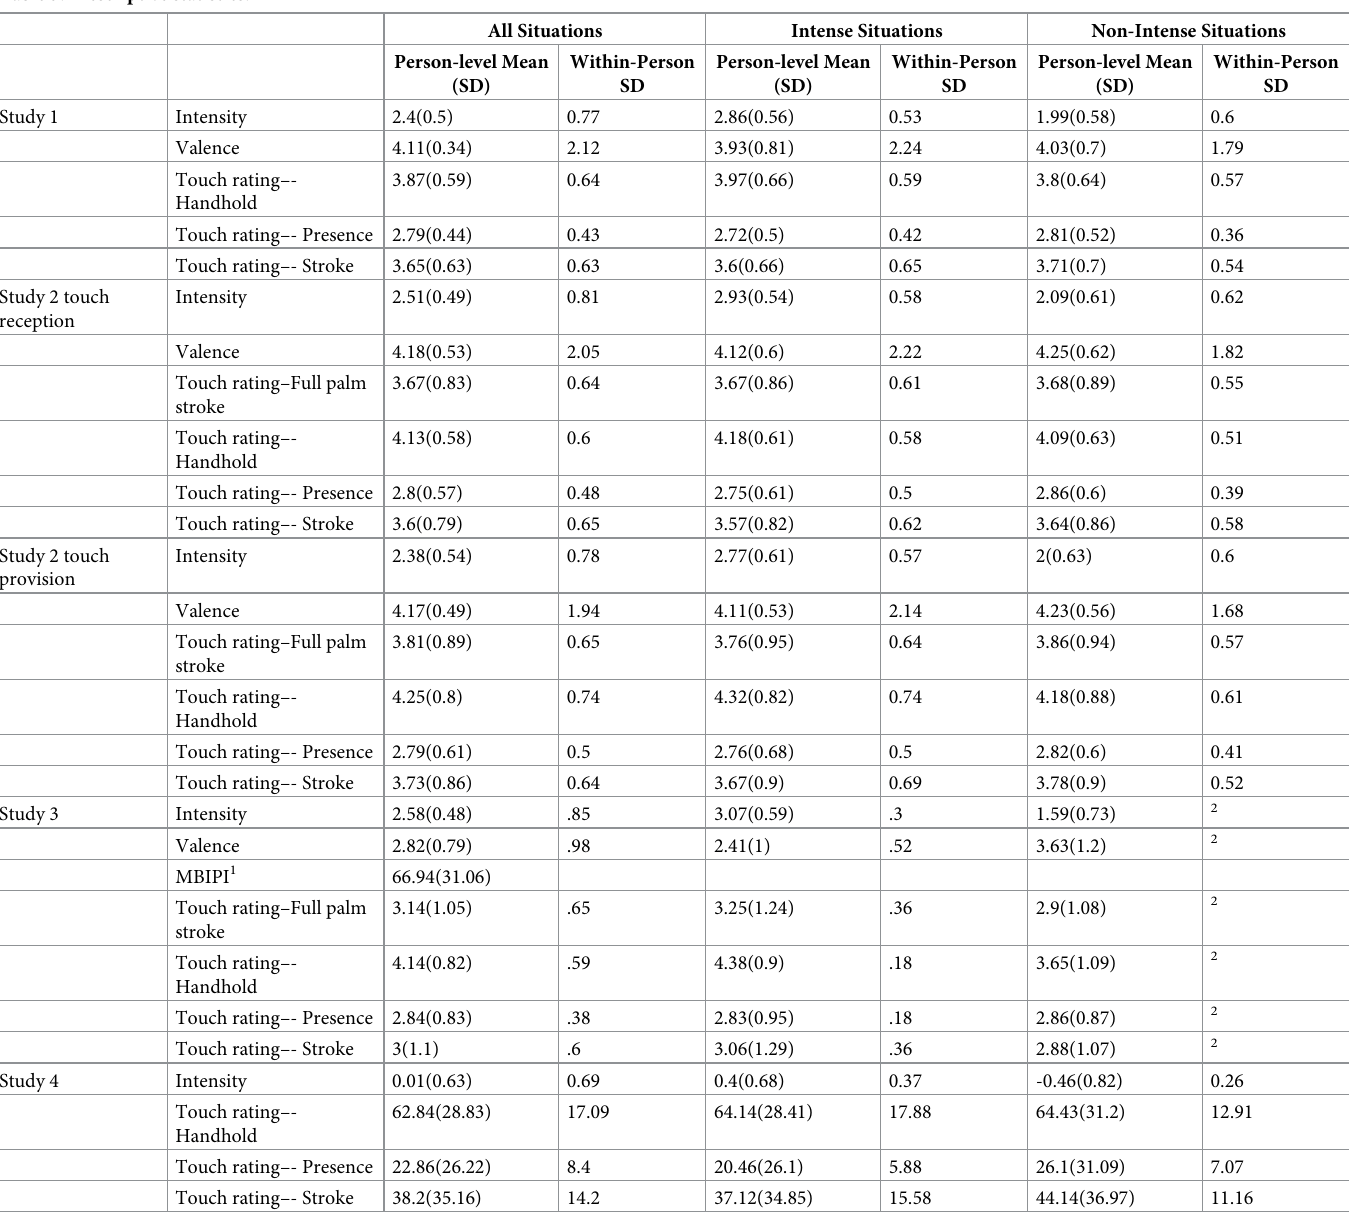
Table 3. Descriptive